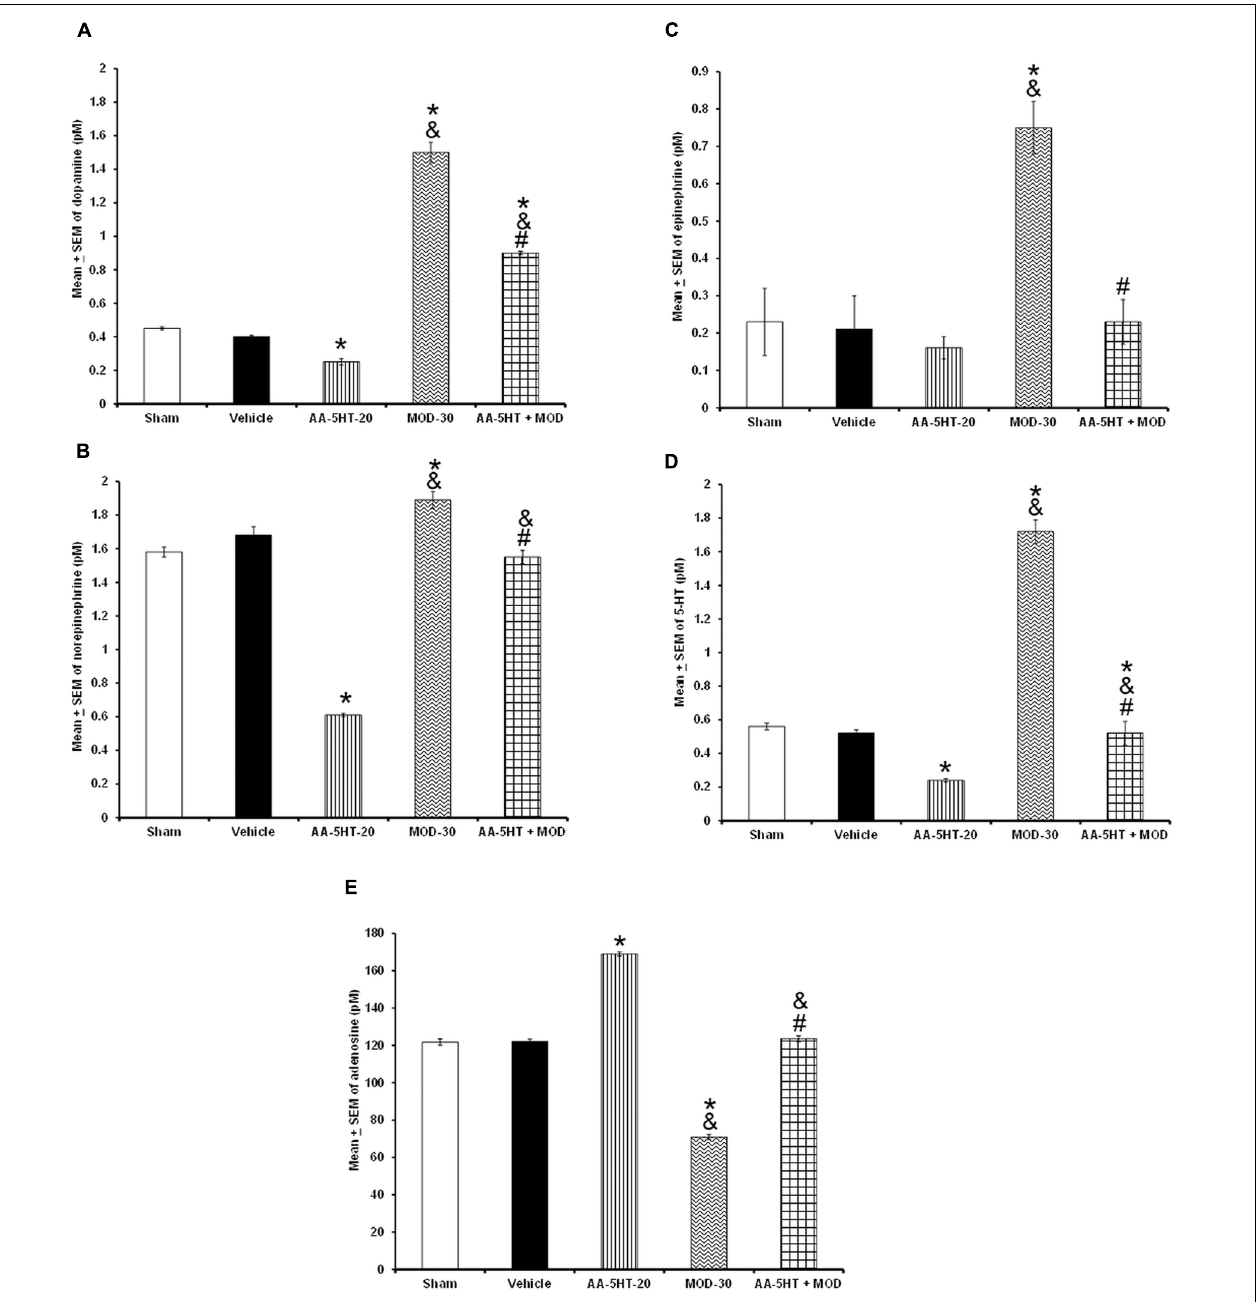
FIGURE 9 | Effects on the extracellular levels of DA, NE, EP, 5-HT, and AD after the administration of AA-5-HT (20 mg/Kg; i.p.), modafinil (MOD; 30 mg/Kg; i.p.) or AA-5-HT (20 mg/Kg; i.p.), and 15 min MOD (30 mg/Kg; i.p.) at the beginning of the lights-on period. AA-5-HT decreased the extracellular contents of catecholamines whereas increased levels of AD. On the other hand, MOD induced opposite effects. Importantly, administration of AA-5-HT before the injection of MOD partially was able to prevent the increase in levels of DA, NE, EP, 5-HT, and blocked the decrease of AD contents ( A–E , respectively. Mean ± SEM ∗ vs. Sham/Vehicle, P < 0.05; & vs. AA-5-HT-20, P < 0.05; # vs. MOD-30, P < 0.05). Abbreviations: Modafinil 30 mg/Kg, i.p. (MOD-30), AA-5-HT-20 mg/Kg (AA-5-HT-20).